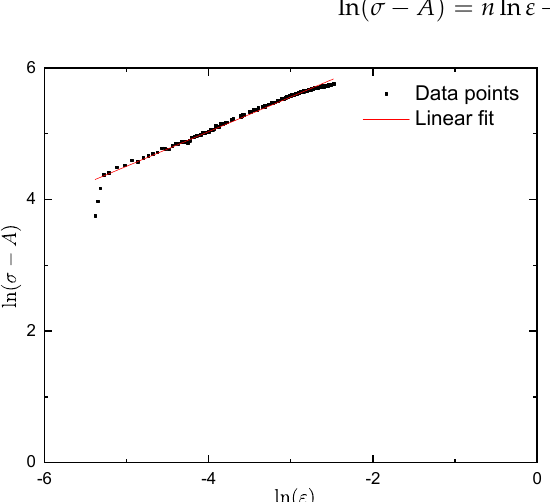
Figure 8. ln( σ − A) and ln ε relationship under reference conditions. Figure 8. ln( σ − A ) and ln ε relationship under reference